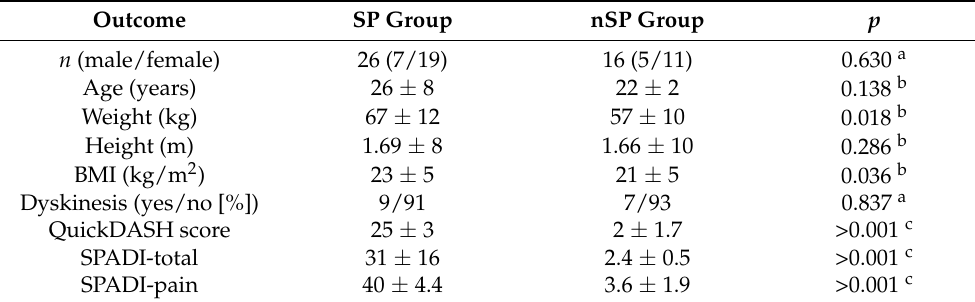
Table 1. Participants’